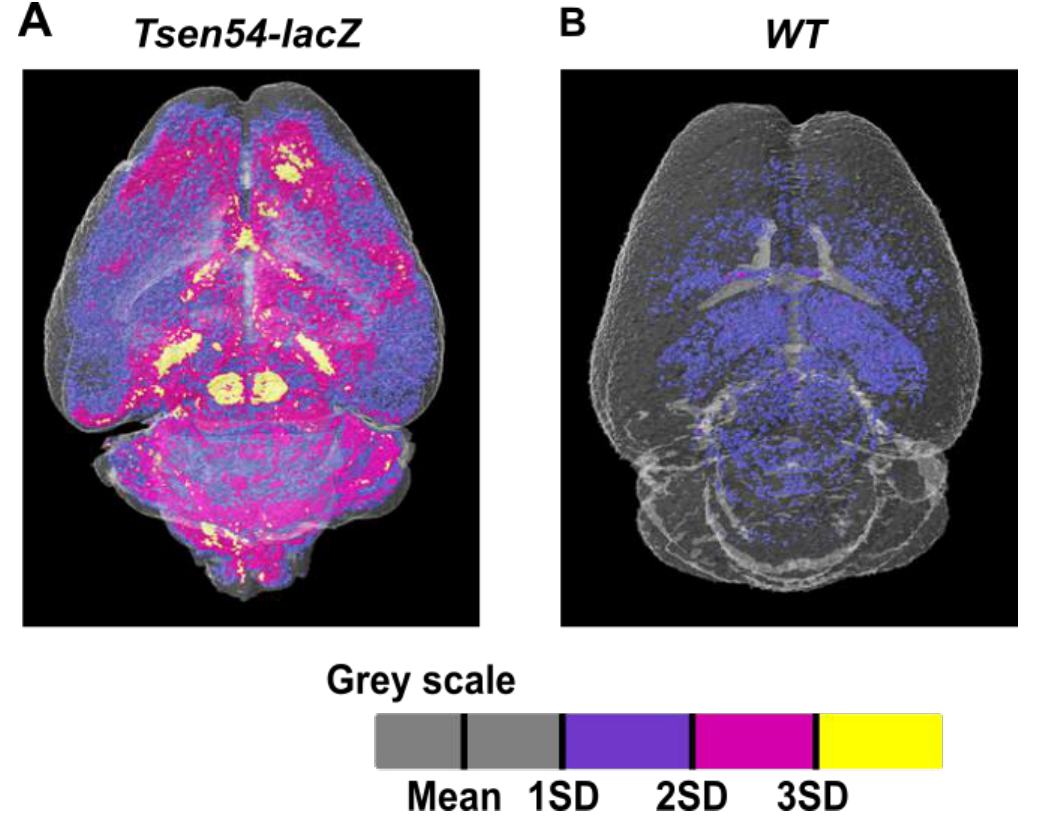
Figure 4. Relative quantification of Tsen54-lacZ gene expression by micro-CT analysis. ( A , B ) The average grayscale values were calculated using three datasets from the Tsen54-lacZ brains using CTAN (Bruker) software. The sum of the average mean and one standard deviation was set up as a background of non-contrasted tissues (gray), while values outside of this range were color-coded: 1SD(Standard Deviation) to 2SD—blue (lowest brightness); 2SD to 3SD—magenta (intermediate); and 3SD and above (maximum)—yellow. These calculated values were applied to the datasets obtained from the Tsen54-lacZ ( A ) and wild type ( B ) brains. Resolution of the micro-CT original images is 20 m/voxel.